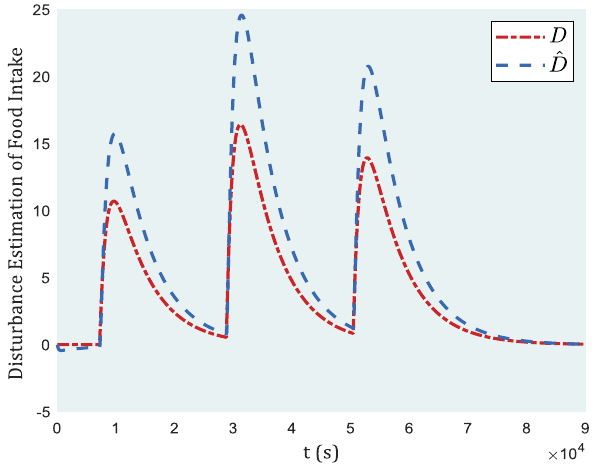
Figure 9. Estimation of blood glucose induced by meals as a disturbance in the presence of actuator faults.